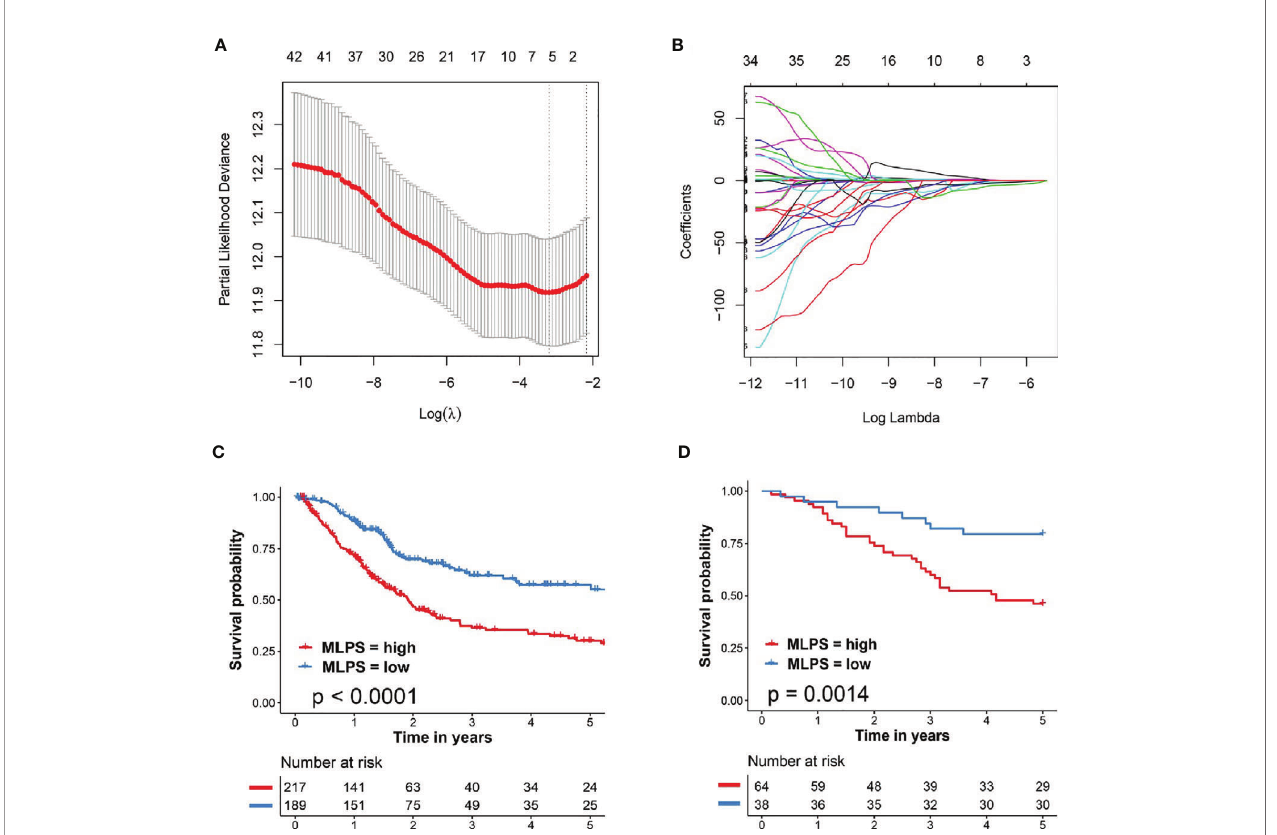
FIGURE 2 | Developed and veri fi ed the pathomics-based prognosis model for BCa. (A, B) The tenfold cross-validated error and the pro fi le of coef fi cients in the model at varying levels of penalization plotted against the log (lambda) sequence for least absolute shrinkage and selection operator analysis. (C) Kaplan – Meier survival analysis of overall survival predicted by pathomics-based prognosis model for BCa patients in the TCGA cohort. (D) Kaplan – Meier survival analysis of overall survival predicted by pathomics-based prognosis model for BCa patients in the validation cohort (General cohort). BCa, bladder cancer; TCGA, The Cancer Genome Atlas; MLPS, machine learning-based pathomics